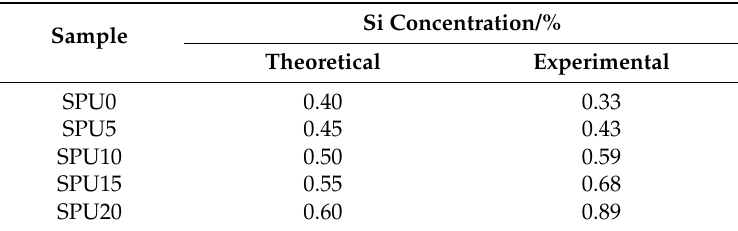
Table 3. Theoretical and experimental EDS results of SPU